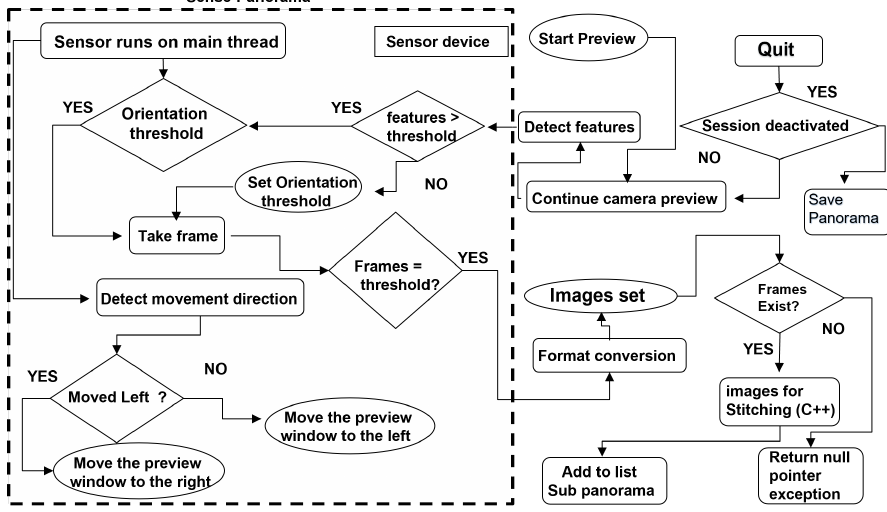
Figure 3. The overall workflow of the Sense-Panorama